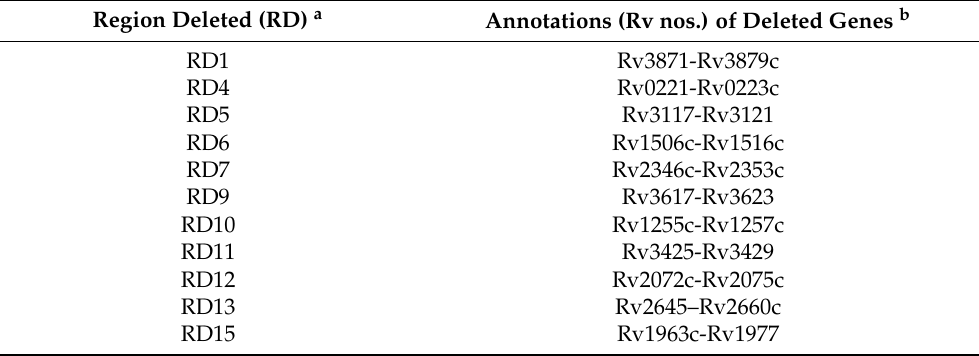
Table 1. M. tuberculosis genomic regions deleted in all strains of Bacillus Calmette Guerin (BCG)